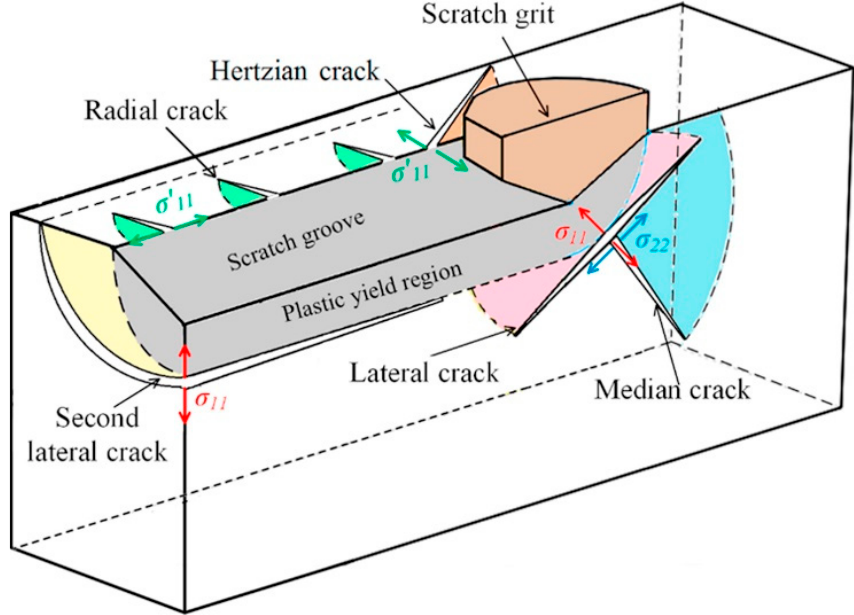
Figure 4. Distribution of the stresses and cracks in the single abrasive scratching of fused silica [27].